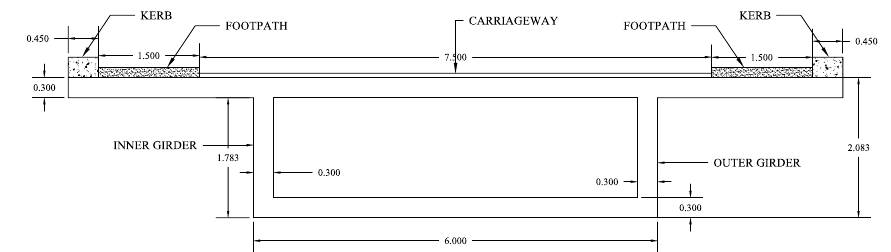
Fig. 5 Model of box-girder bridge deck for present study